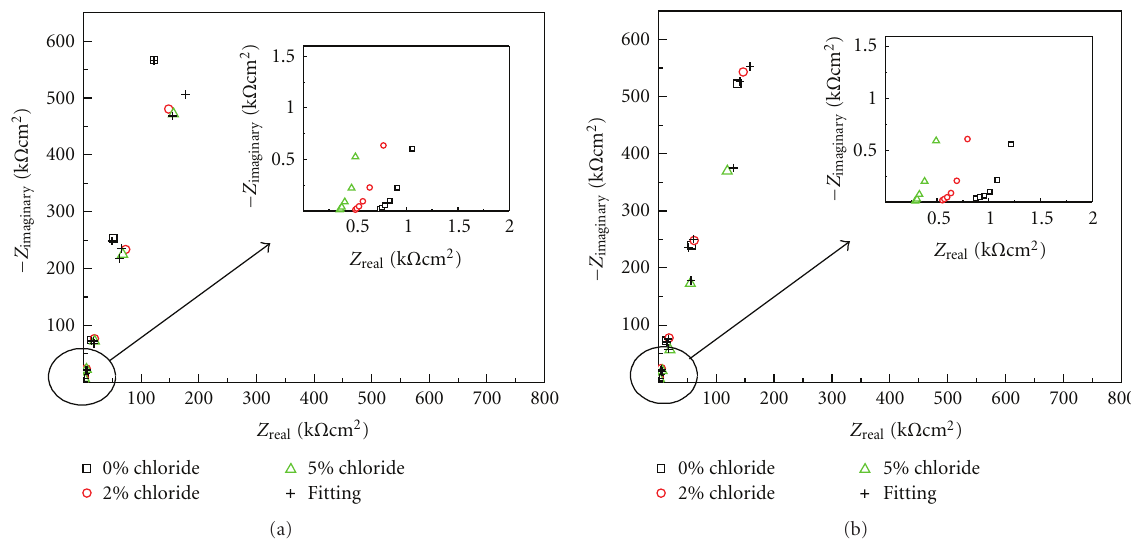
Figure 4: Nyquist plots for low-nickel SS for low-nickel SS rebar embedded in mortars (a) A and (b) B with di ff erent chloride additions.